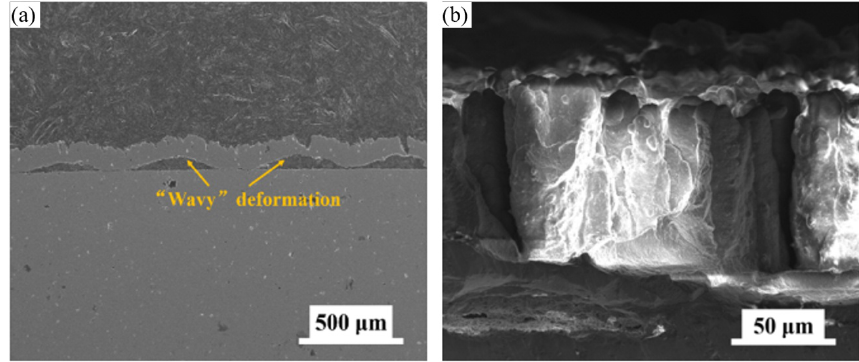
Fig. 54 Cross-section morphologies of PS-PVD YSZ after CMAS hot corrosion: (a) separation between coating and substrate and (b) filling of the gap between columns by CMAS. Reproduced with permission from Ref. [289], © China Academic Journal Electronic Publishing House